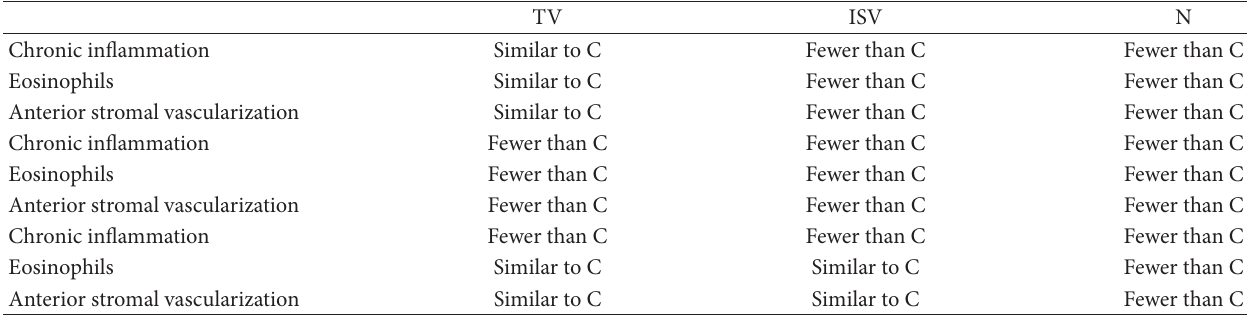
Table 7: The pathological comparison of 9 corneal buttons of the experimental groups with the control group (3 corneal buttons from each experimental